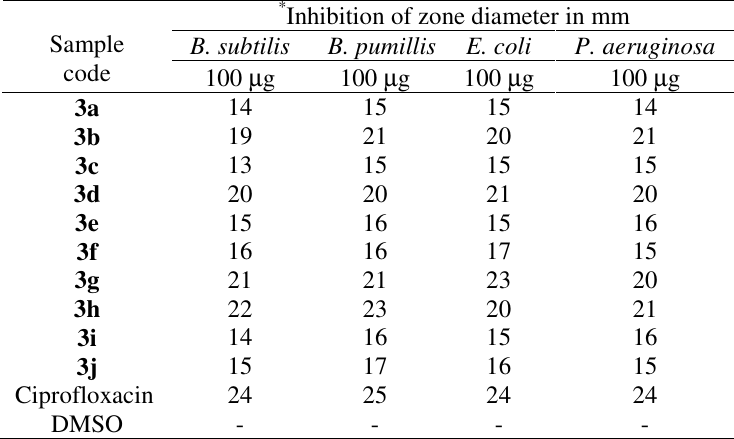
Table 2. Antibacterial activity of compounds 3a-j